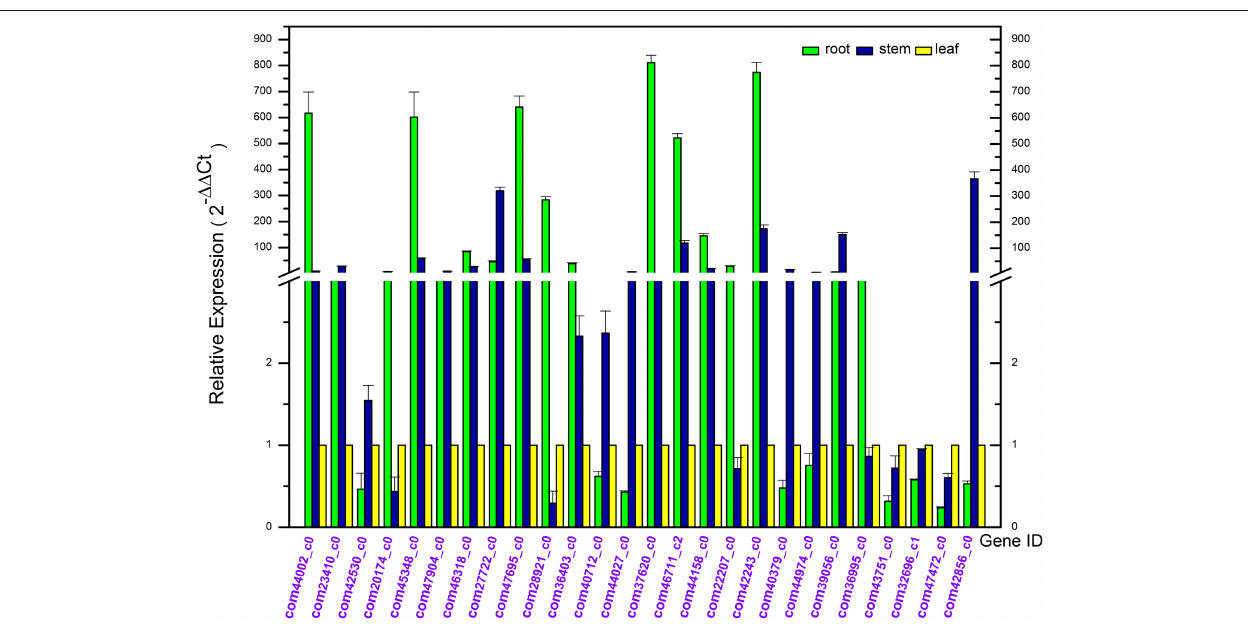
FIGURE 9 | Differential expression analysis of putative unigenes in the root, stem, and leave of Dipsacus asperoides by reverse transcript quantitative PCR (RT-qPCR).